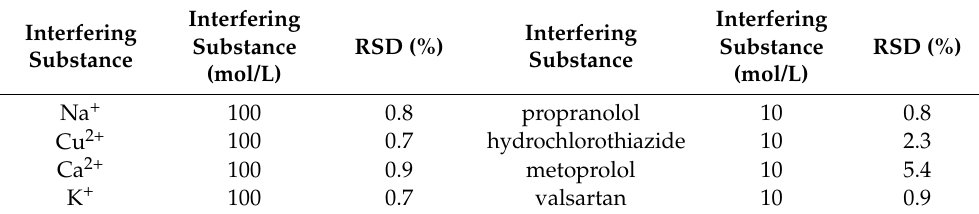
Table 3. Influence of coexisting